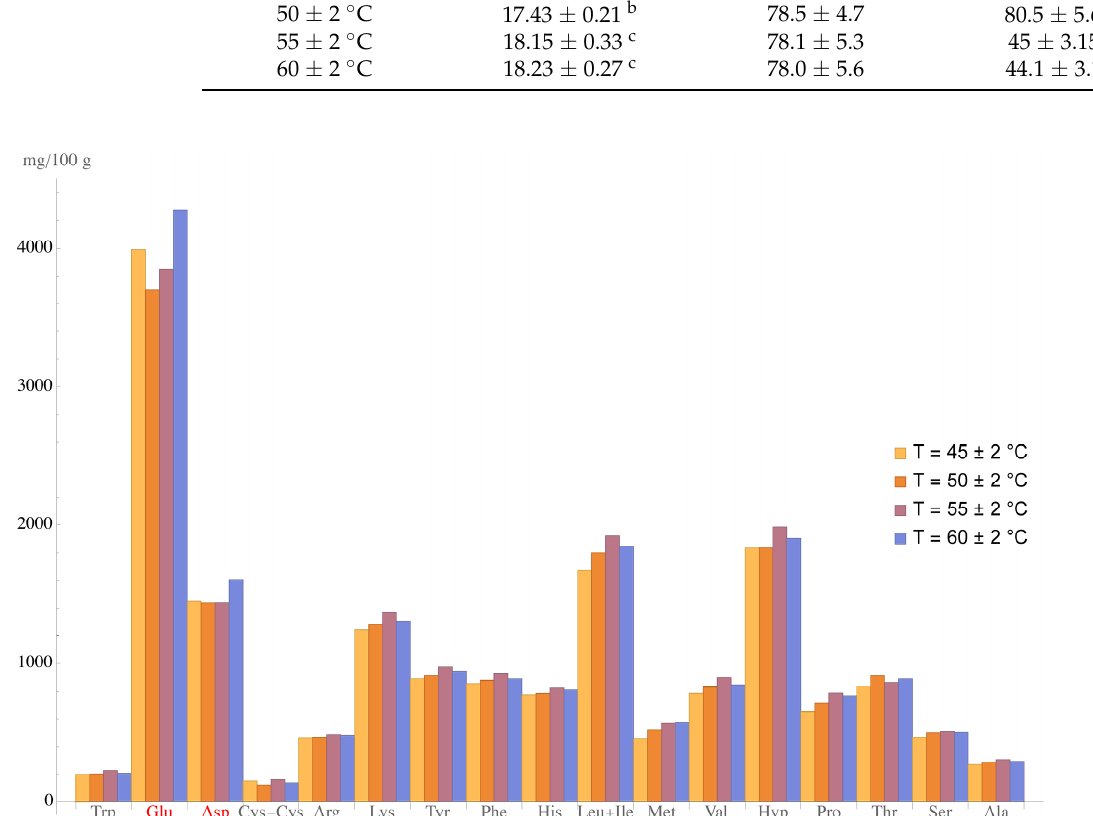
Figure 3. Amino acid profiles of the acid curd samples, heating temperatures: 45 ± 2 °C, 50 ± 2 °C, 55 ± 2 °C, 60 ± 2 °C. Red: amino acids with content in the sample made at 60 ± 2 °C that was statisti- cally different from the other samples (ANOVA test and Tukey’s post hoc test). Their number of amino acids tended to increase as the curd was heated up to 60 ± 2 °C.